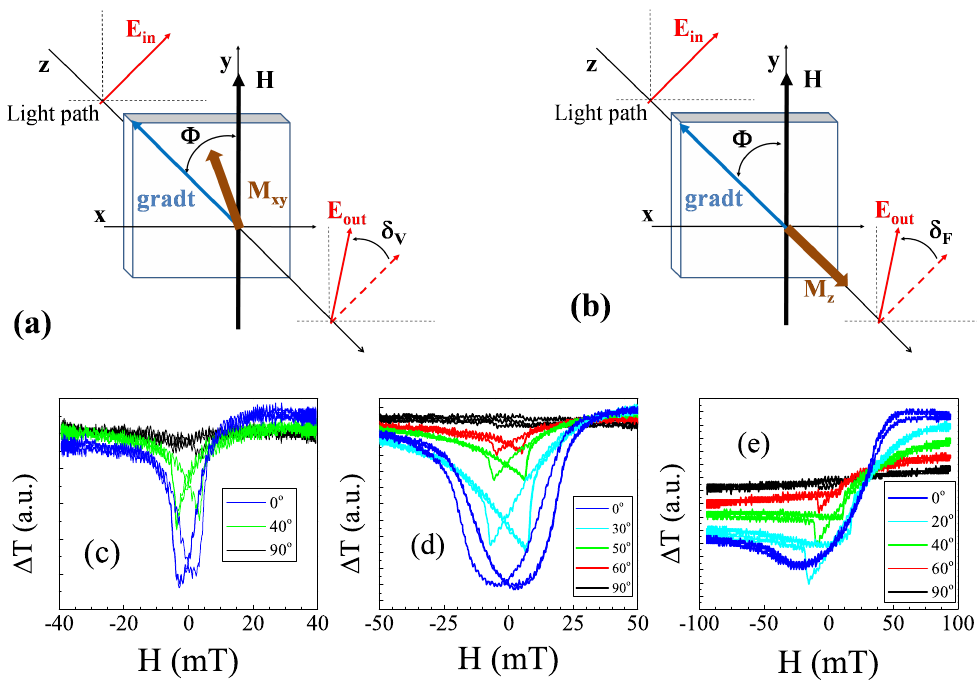
Figure 8. Panels ( a , b ) show respective rays and angle diagrams for MOVE and MOFE measurements in transmission configuration, where the light path is always along z-axis. Panels ( c – e ) show the recorded intensity of the transmitted light at the differential amplifier circuit for P6, P4, and P3, respectively. In all cases, legends indicate Φ